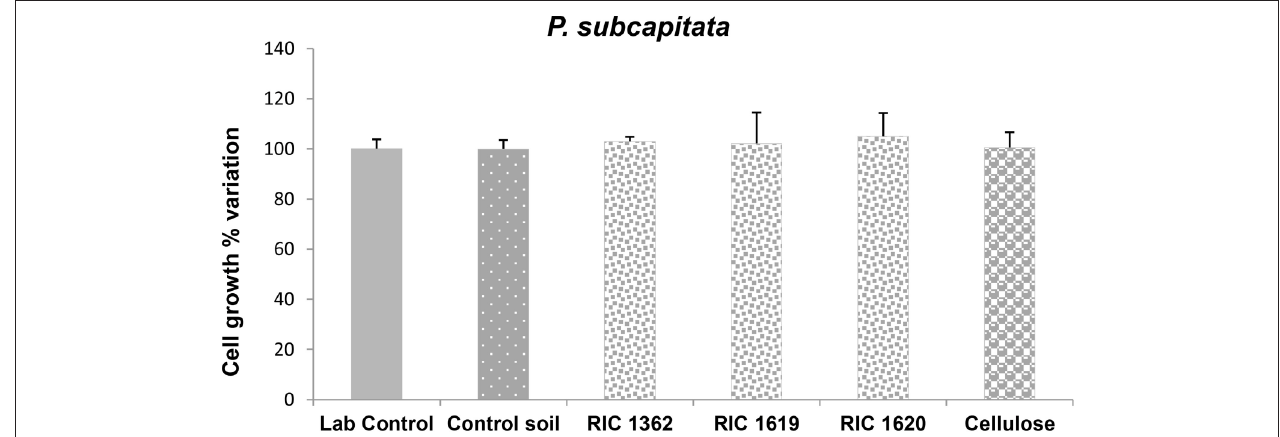
FIGURE 5 | Growth of the alga P. subcapitata after exposure to the elutriate samples. Data are expressed as % variation with respect to lab control and represent the mean ± SD of at least five replicates. *Indicates statistically significant differences with respect to lab control values ( p < 0.05 Mann–Whitney U -test). RIC 1362, RIC 1619, RIC 1620, Mater-Bi soils; Cellulose, soil containing cellulose reference material.